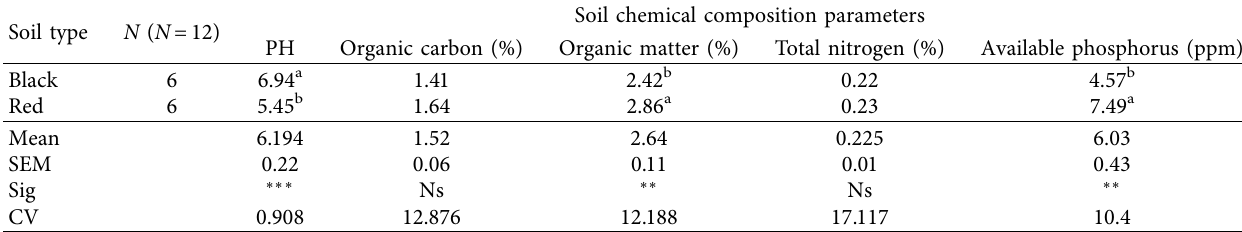
Table 1: Soil sample chemical composition of experiment sites before planting.